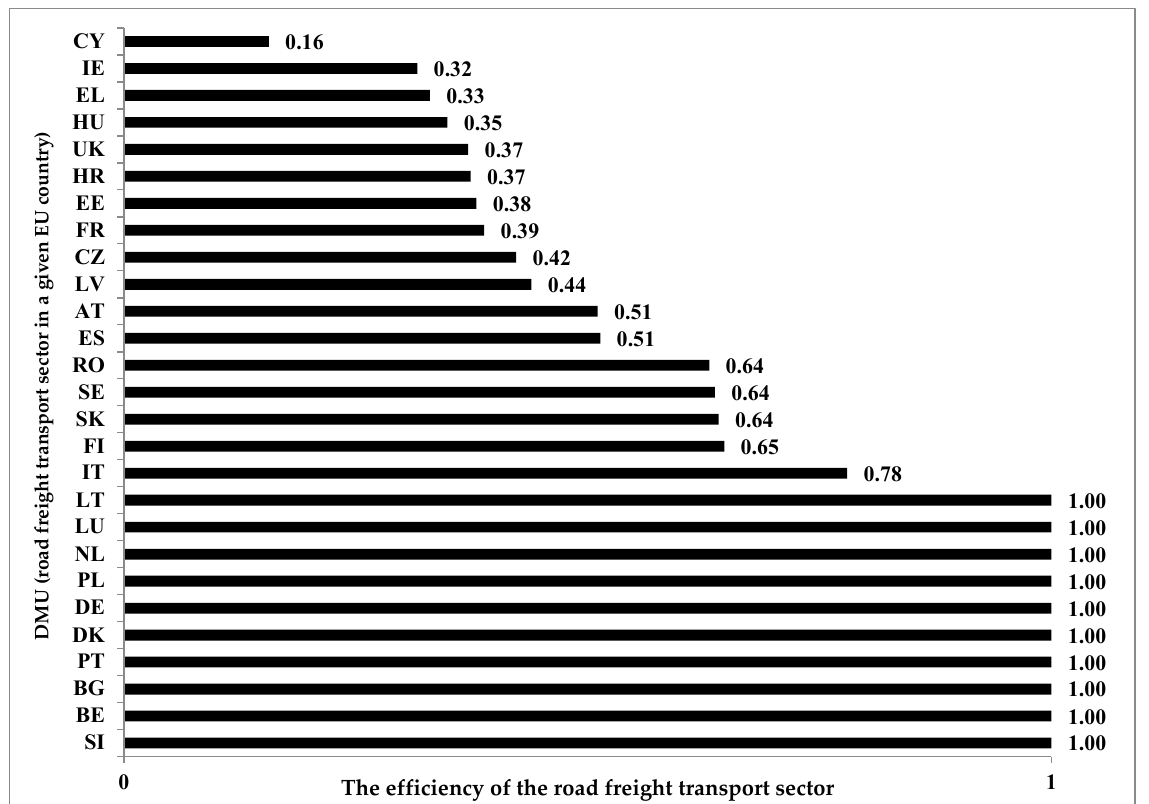
Figure 12. Efficiency of road freight transport sectors in EU countries in 2019 according to the SBM-DEA model. Source: Own elaboration.